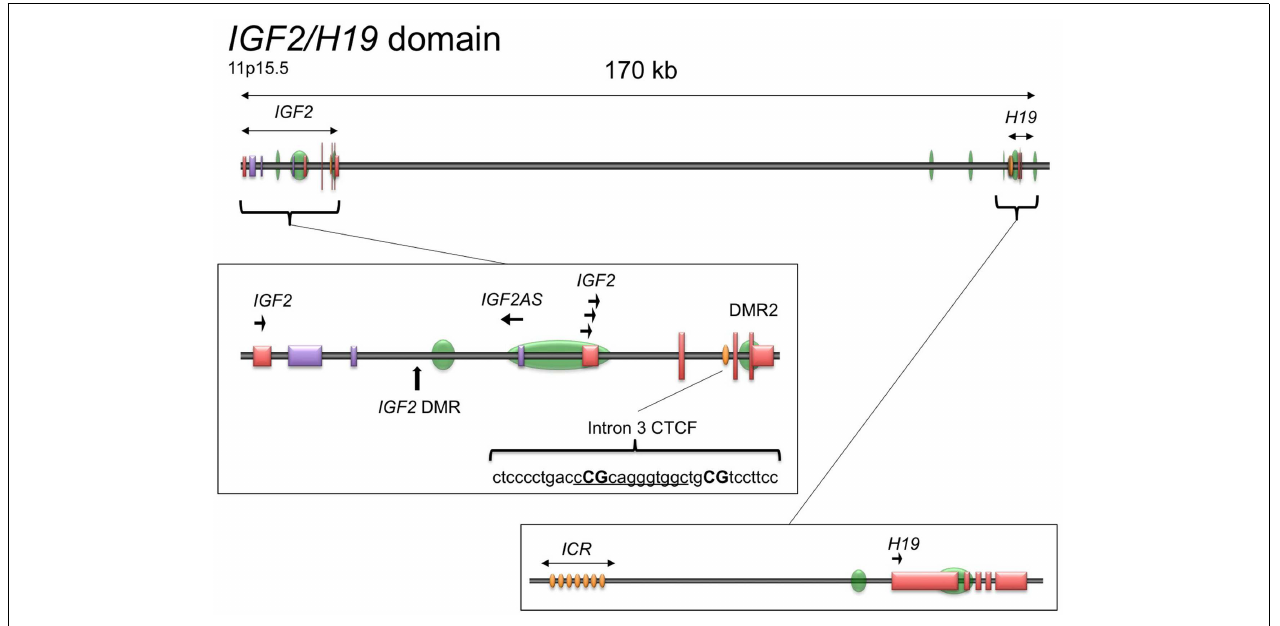
lines/boxes, non-coding sequence.The promoters with direction of transcription are indicated by arrows.The IGF2 locus also produces a paternally expressed antisense transcript ( IGF2AS ), indicated by the purple lines/boxes.The IGF2 intron 3 CTCF binding motif is shown as underlined sequence with the CpG dinucleotides analyzed herein in capital letters. DMR, differentially methylated region; ICR, imprint control